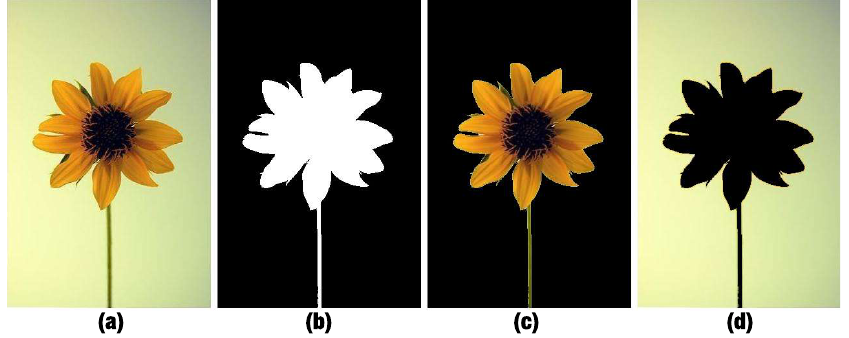
Figure 15. Examples of the two generated versions based on ROIE. ( a ) The original image. ( b ) The ROI map. ( c ) The first version. ( d ) The second